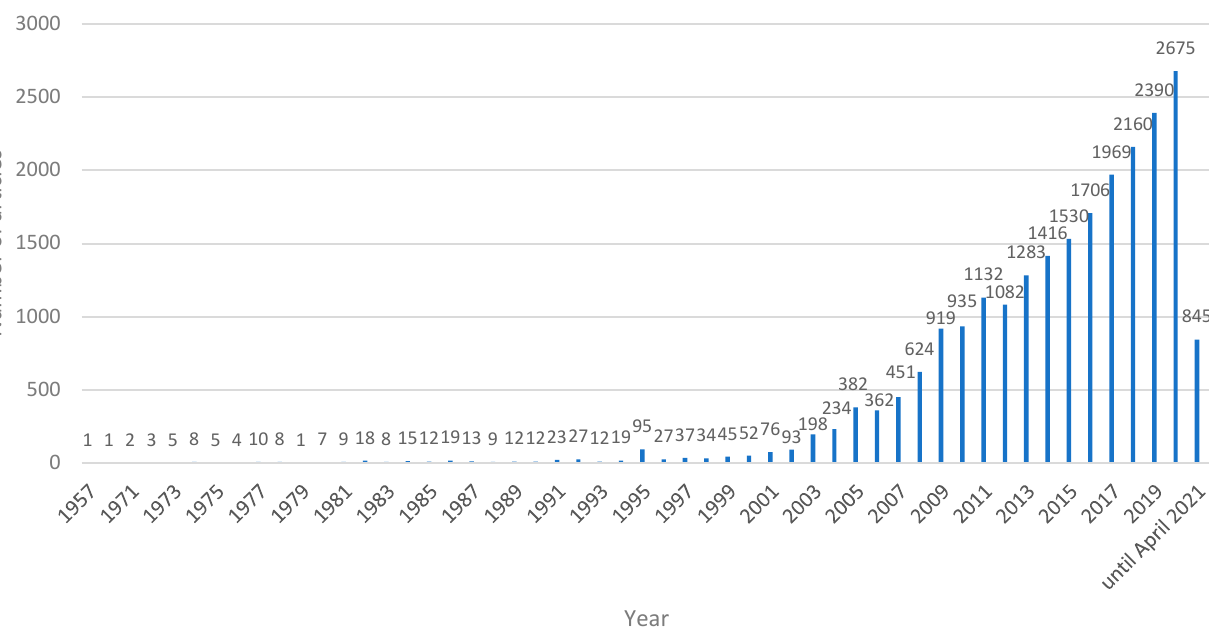
Figure 1. Publications on corporate social responsibility according to the SCOPUS database for the query corporate AND social AND responsibility. Source: Own study based on data from Scopus database (accessed on 1 April, 2021).